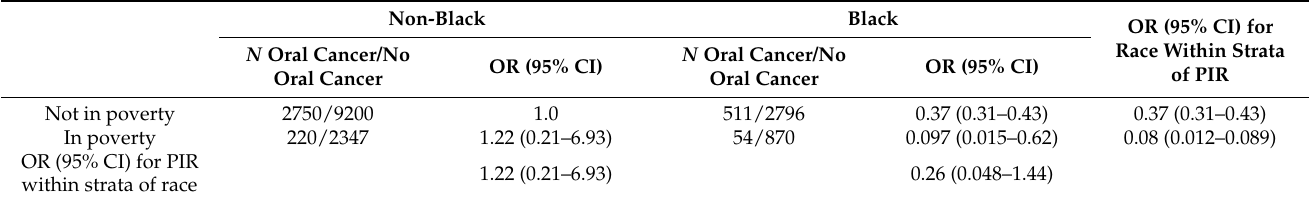
Race Within Strata of PIR